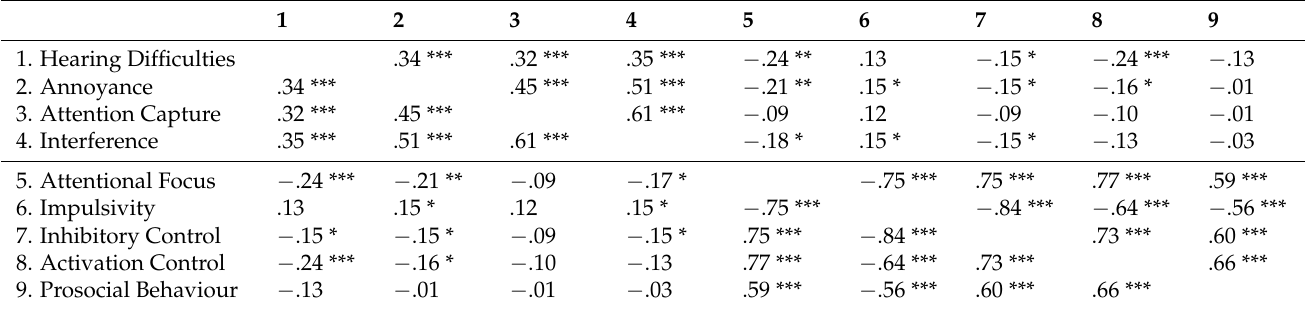
Table 4. Correlations between all the variables used in Study